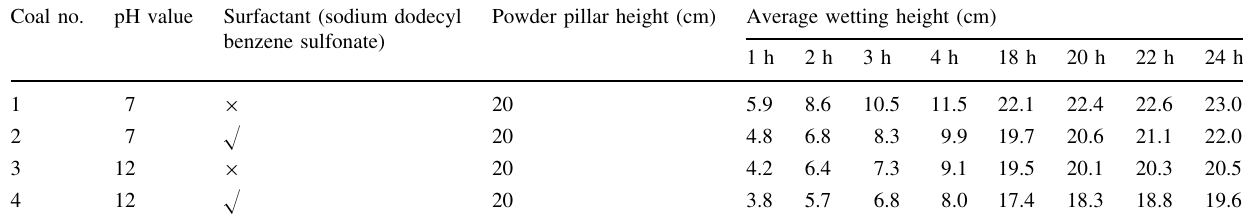
Table 6 Pulverized coal’s average wetting height in different solutions Coal no.